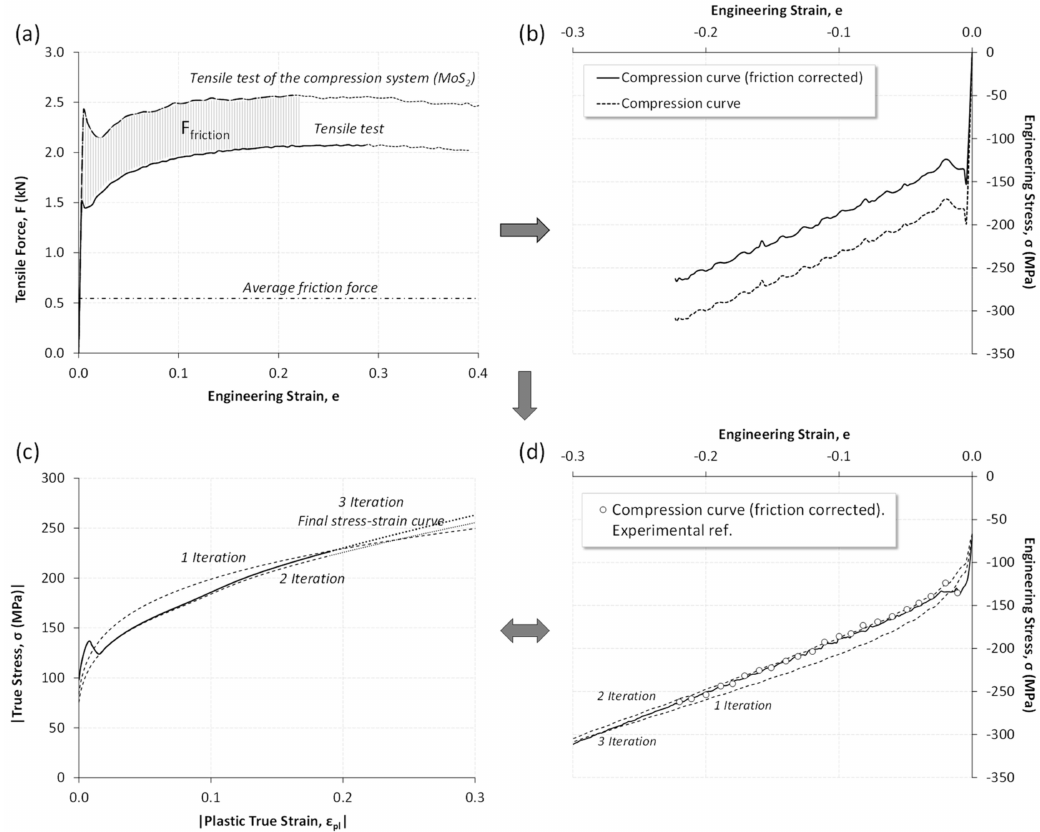
Figure 6. Processing procedure of the compression stress–strain curve of Ticp2 at 300 ◦ C and 0.002 s − 1 . ( a ) Determination of the friction force by means of specific tensile tests; ( b ) frictional force correction in the compression curve; ( c ) iterative steps corresponding to the inverse method; ( d ) engineering curve obtained after each iteration of the inverse method.